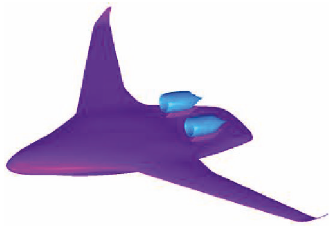
Figure 1: BWB300